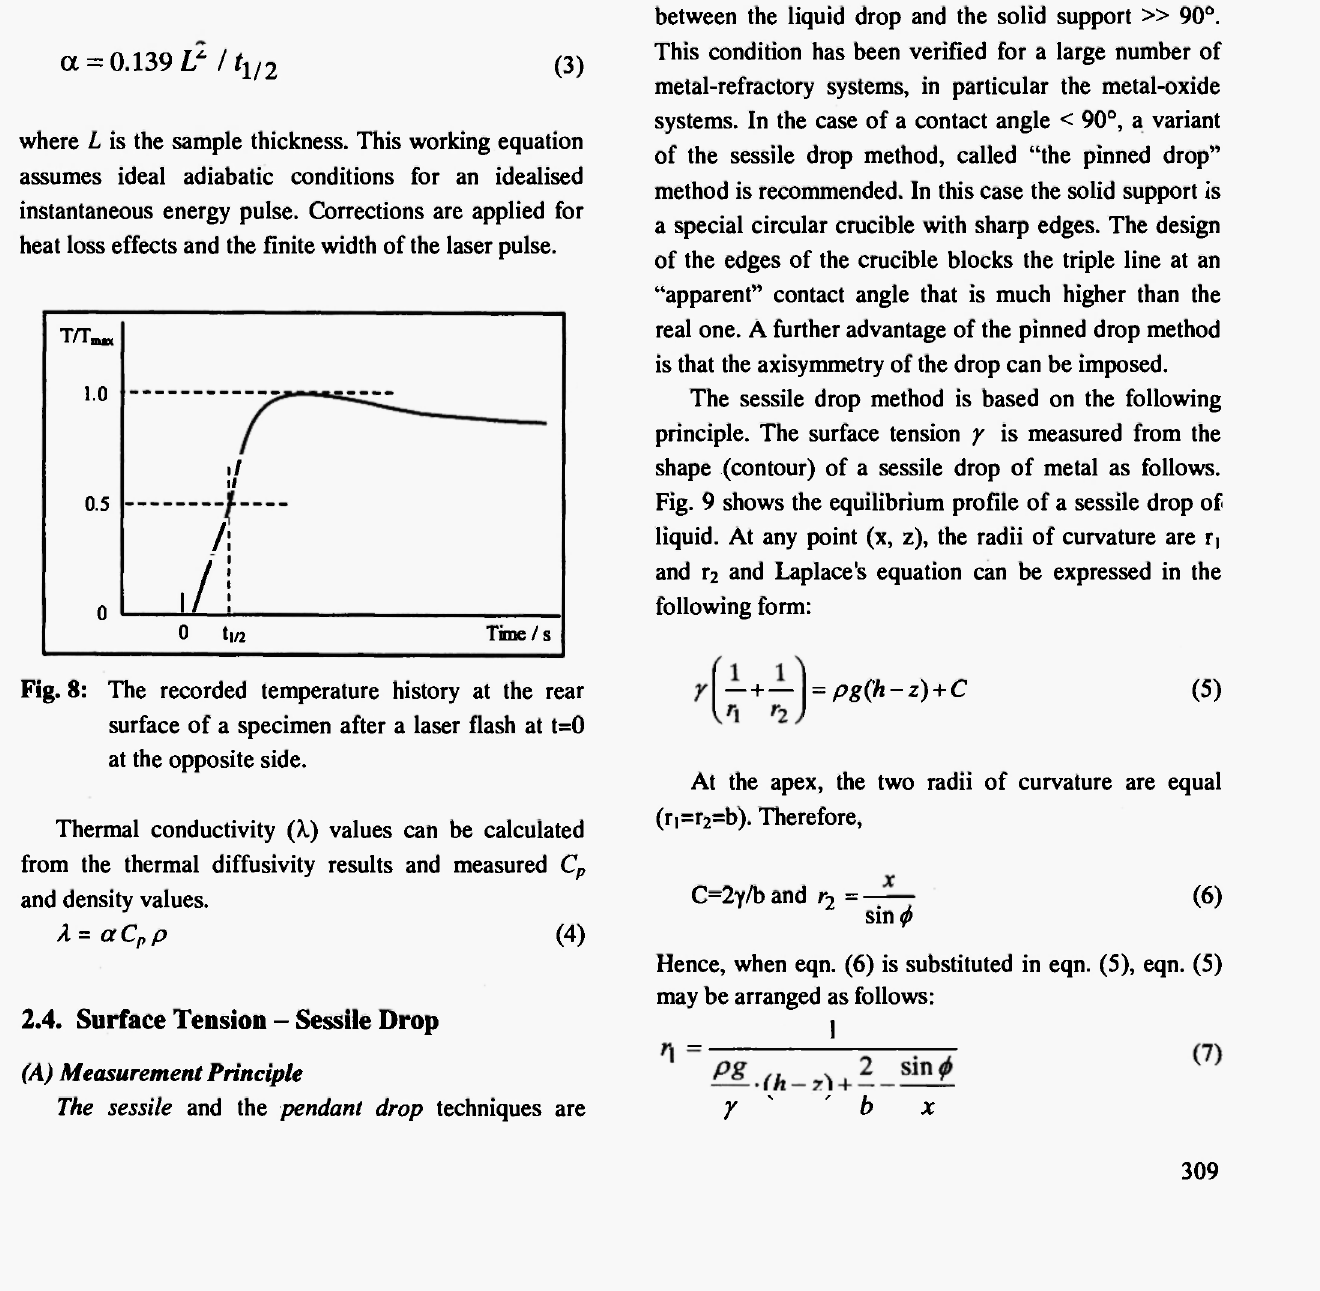
Fig. 8: The recorded temperature history at the rear surface of a specimen after a laser flash at t=0 at the opposite